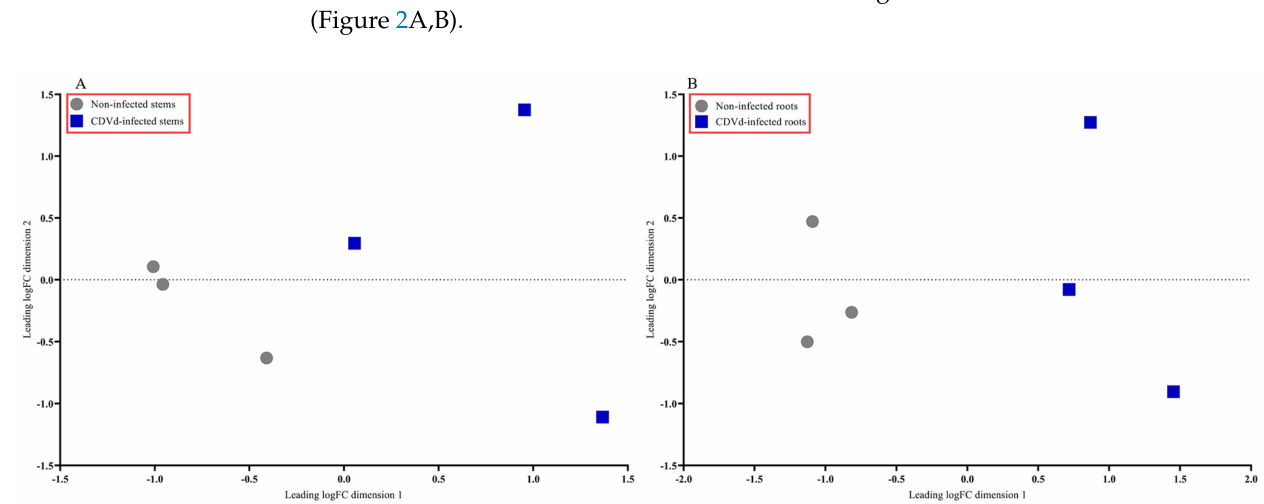
Figure 2. Multidimensional scaling (MDS) plot displaying similarity in leading log fold change in non-infected versus citrus dwarfing viroid (CDVd)-infected ( A ) stem and ( B ) root tissues. Volcano plots were generated to display the number of up and downregulated DEGs by plotting the log fold change (FC) against the negative log (10)-transformed false discovery rate (FDR) values (Figure 3). Samples with high negative log (10)-transformed FDR values indicate DEGs with more significant regulation in response to CDVd-infection. Positive FC values indicated upregulated DEGs (FDR < 0.05; logFC > 1.0), while negative FC values indicated downregulated ones (FDR < 0.05; logFC < − 1.0). Most upregulated DEGs were